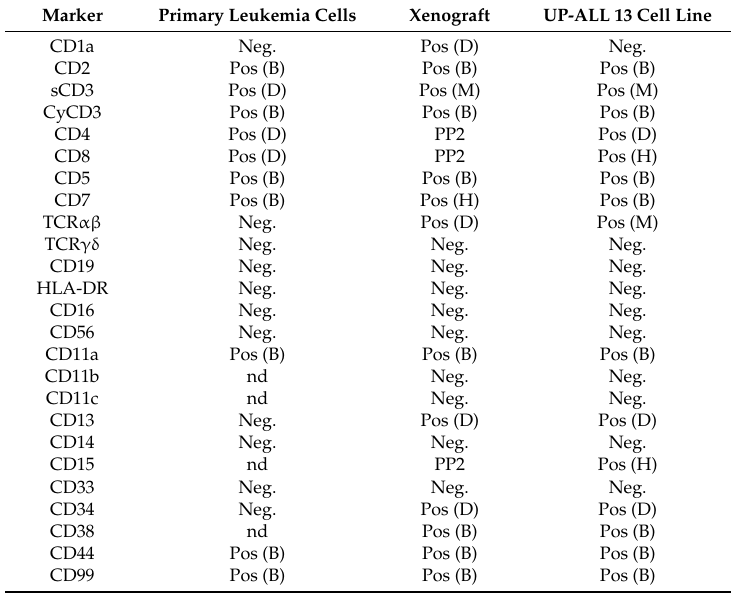
Table 1. Immunophenotype of parental leukemia T-cells, xenograft cells, and the UP-ALL13 cell line. Marker Primary Leukemia Cells Xenograft UP-ALL 13 Cell Line CD1a